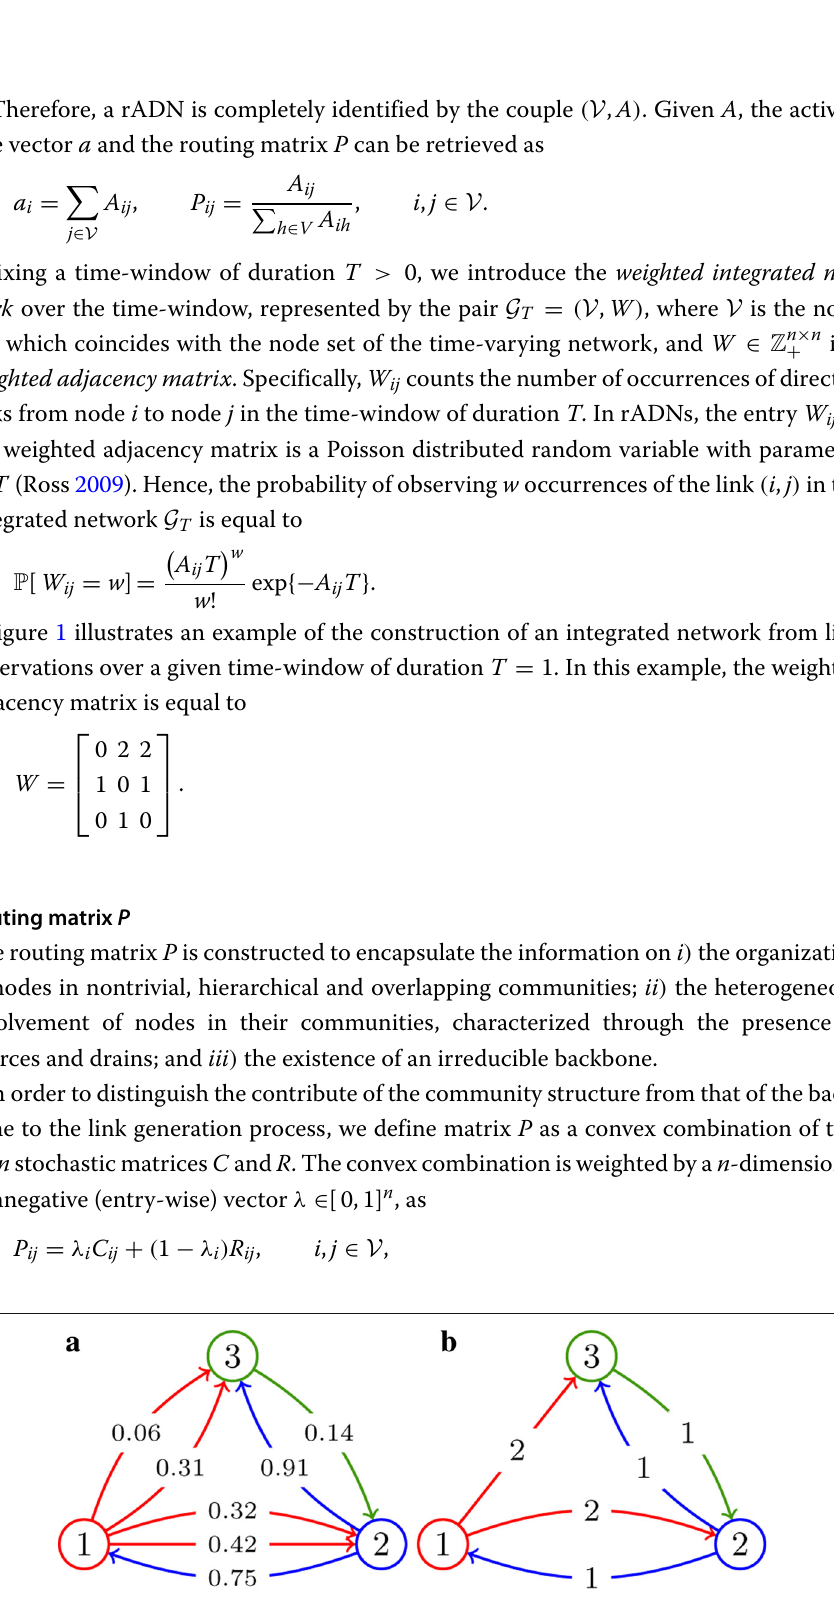
Fig. 1 Exemplification of the construction of an integrated network in a time-window of duration T = 1. In ( a ), occurrences of links are plotted separately, along with their time-stamps (2 decimal digits). In ( b ), the integrated network G T is illustrated. Weights represent the number of occurrences of each link in the